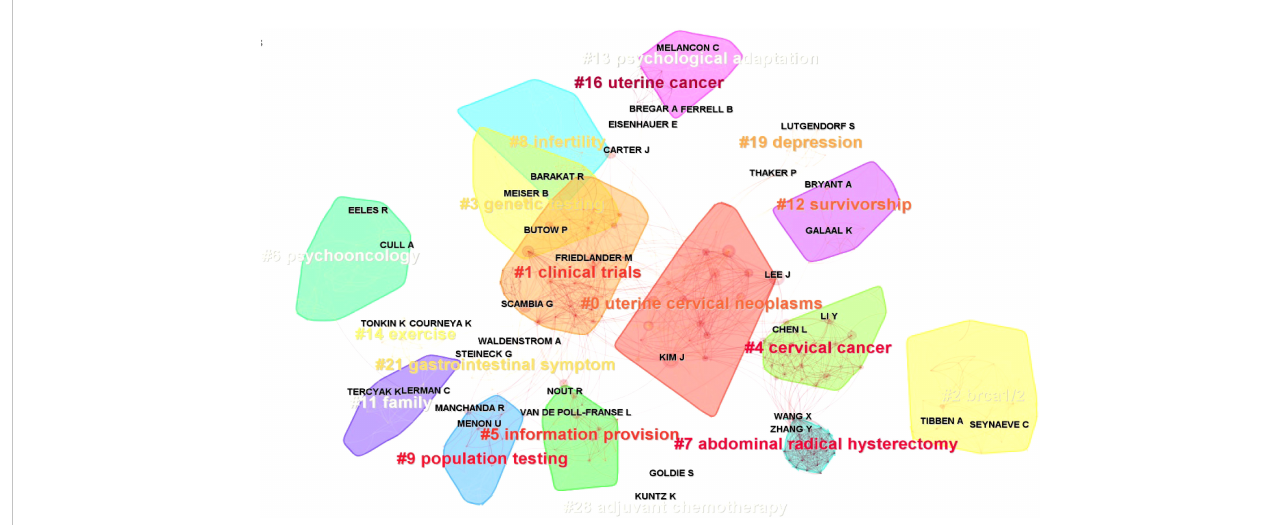
FIGURE 8 The network of authors involved in quality of life (QoL) or mental health of gynecologic oncology patients.